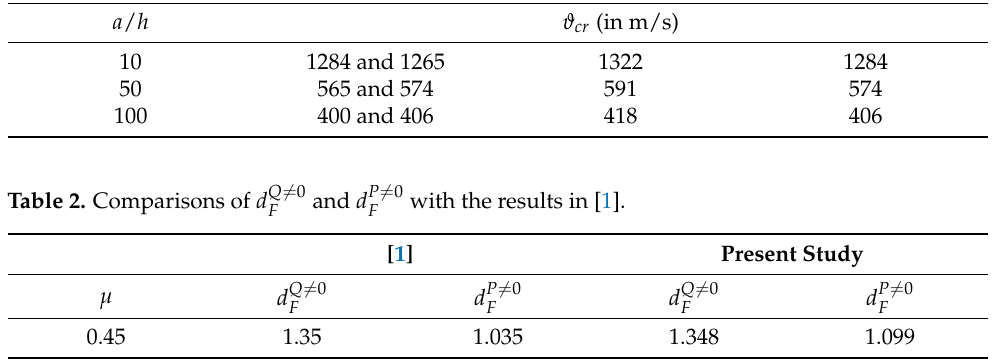
Table 1. Comparisons of the critical velocity with the results of [1,7].